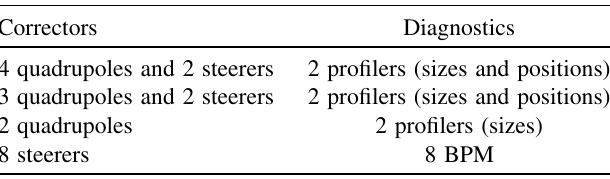
TABLE V. The correction scheme of the HEBT.